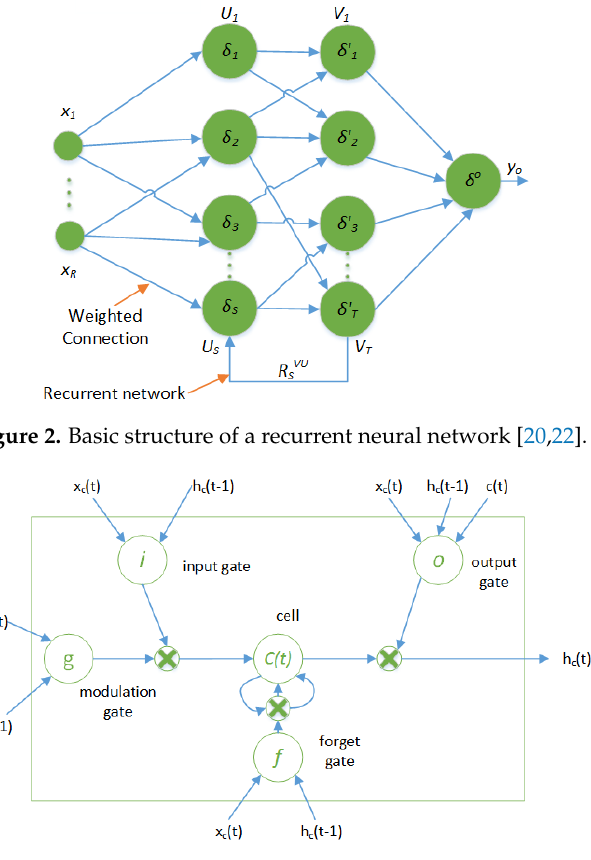
Figure 3. Basic structure of a LSTM-NN cell